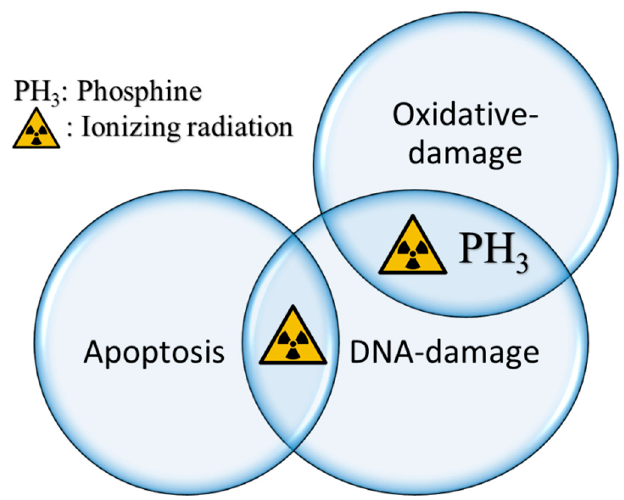
Figure 2. Ionizing radiation results in physical damage to DNA as well as high levels of oxidative stress. Phosphine also causes signi fi cant oxidative stress and has been shown to damage DNA [106]. A C. elegans strain that is resistant to radiation induced apoptosis does not show cross-resistance to phosphine. This indicates that the super fi cial similarity between the modes of action of phosphine and ionizing radiation is not re fl ected in a shared antiapoptotic resistance